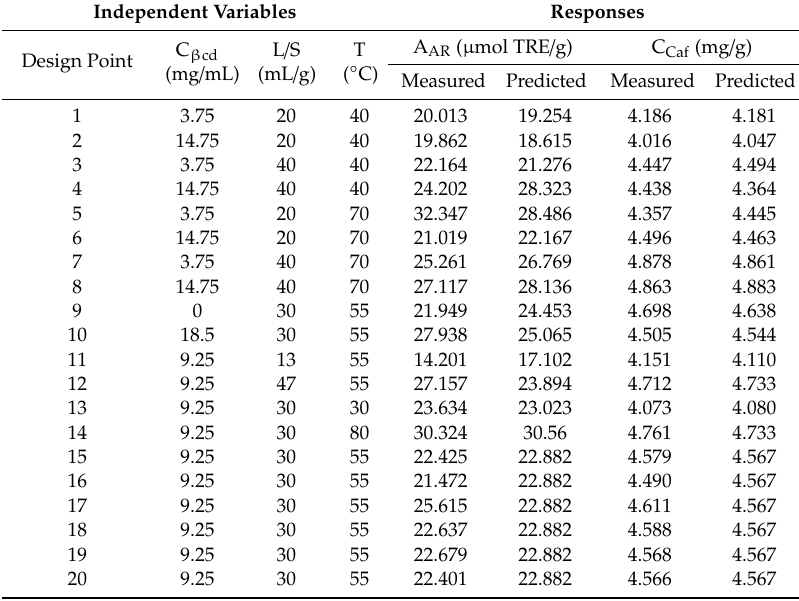
Table 2. Measured and predicted values of extracts antiradical activity (A AR , µ mol TRE * / g) and ca ff eine extraction yield (C Caf , mg / g) for the individual design